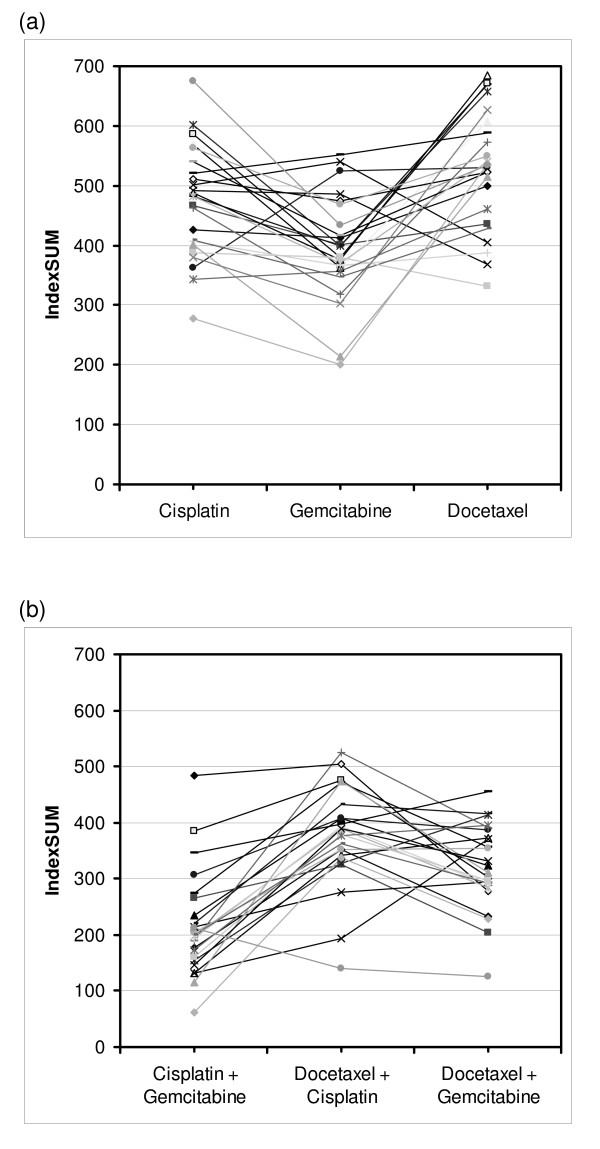
Cross resistance in the ATP-TCA between (a) drugs and (b) combinations, expressed as IndexSUM.